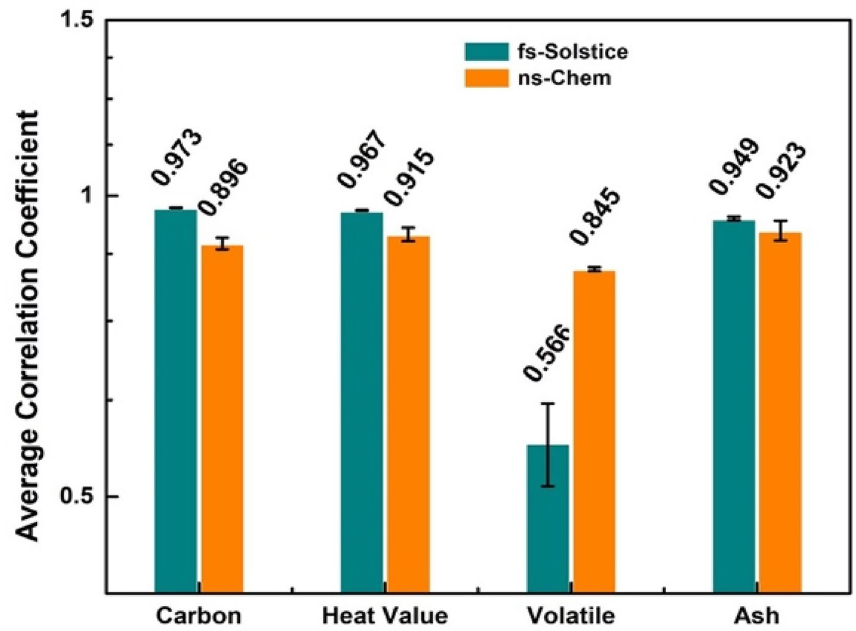
Figure 2. Average of Pearson’s correlation coefficients of 10 most correlated lines to carbon content, heat value, volatile, and ash contents obtained by fs-Solstice and ns-Chem